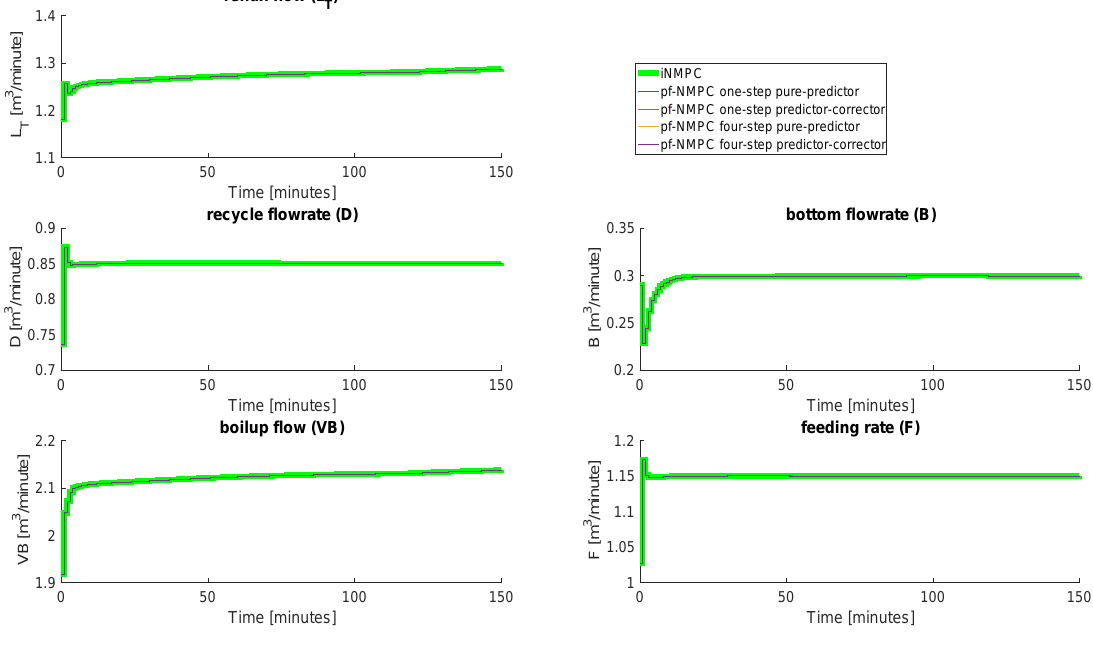
Figure 5. Optimized control inputs.